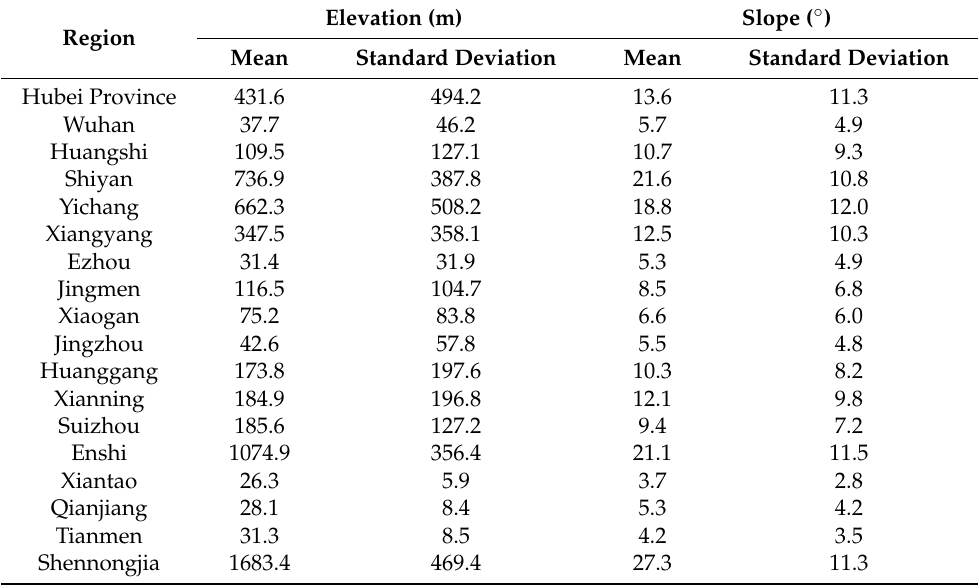
Table 4. Statistics on the elevation and slope in the study area.